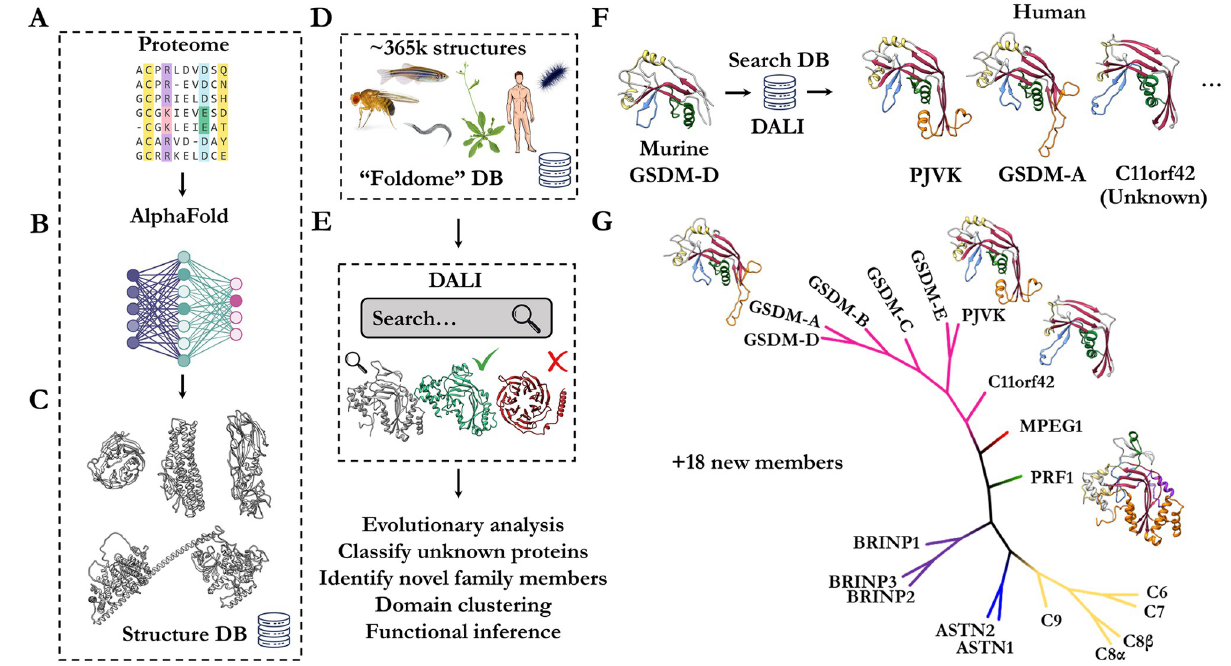
Fig 1. Conceptual overview of structure-guided fold recognition against the AlphaFold database. a. Entire proteome sequence databases are converted by ( b ) machine-learning methods into high-accuracy ( c ) structural model predictions. d . Curation of these structural databases into a unified resource of structures (S1 Text). e. DALI based fold matching to perform functional inference, identification of unknown members and structural classification. f. Searching the foldome in ( d ) for matches of murine GSDM-D N-terminal domain yields MACPF/GSMD family members, including C11orf42 –an unknown member of the GSDM family. g. Example phylogenetic analysis of perforin-like proteins identified from the foldome by DALI. Alignment of the central MACPF/GSDM fold is possible by extracting domain boundaries based on AlphaFold prediction allowing specific comparison between members without interfering ancillary